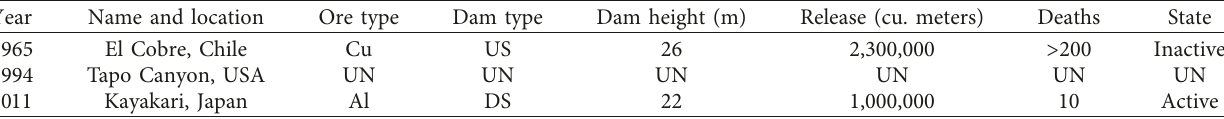
Table 5: Example of tailings dam failure caused by